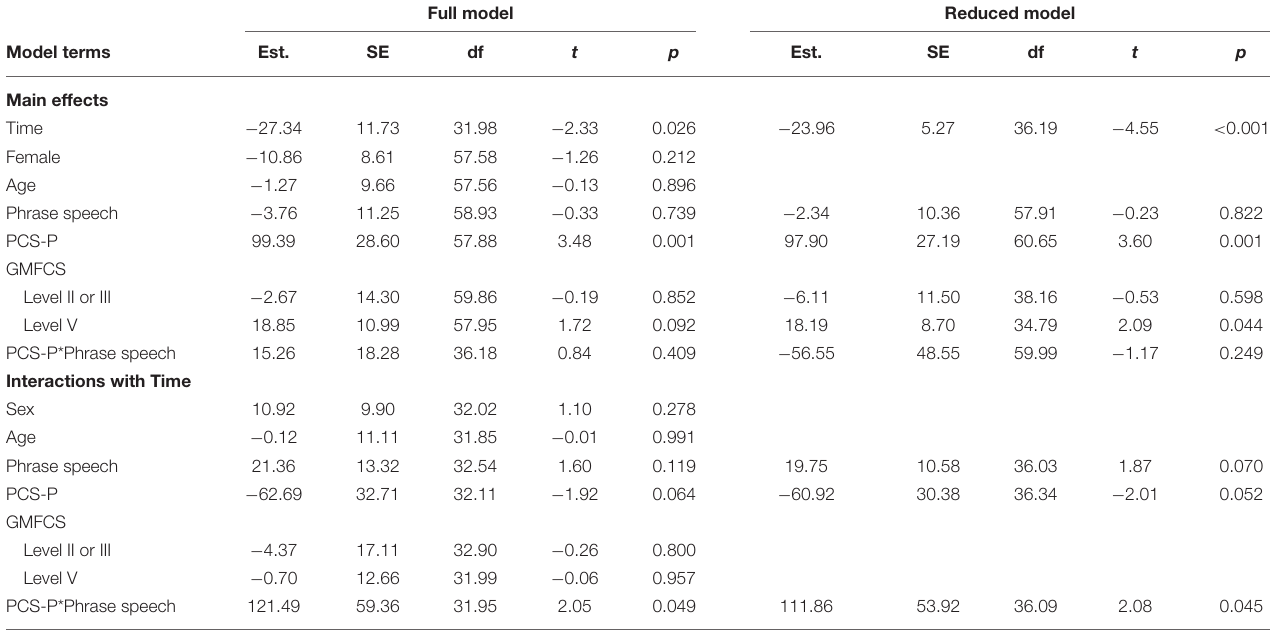
TABLE 4 | Full and reduced linear mixed model results for pain interference scores.